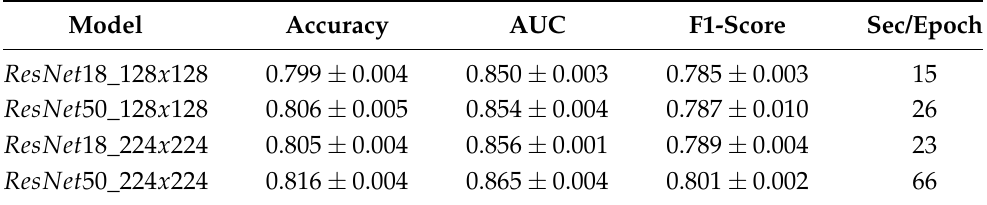
Table 3. Baseline comparison. 5 runs with Tesla T4 gpu and bs =